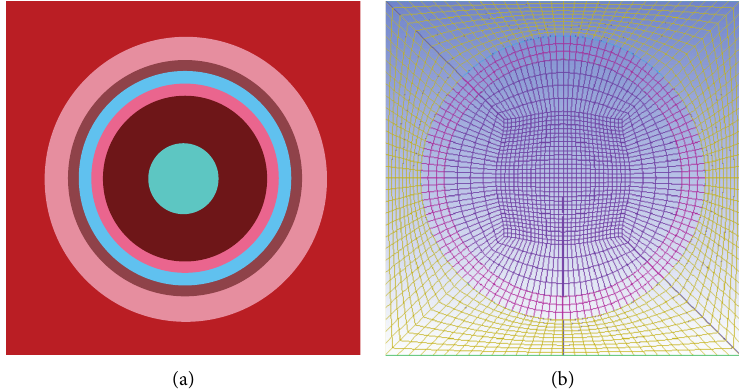
Figure 4: Cell division and meshing for PWR cell model. (a) Cell division in OpenMC. (b) Meshing for FLUENT.